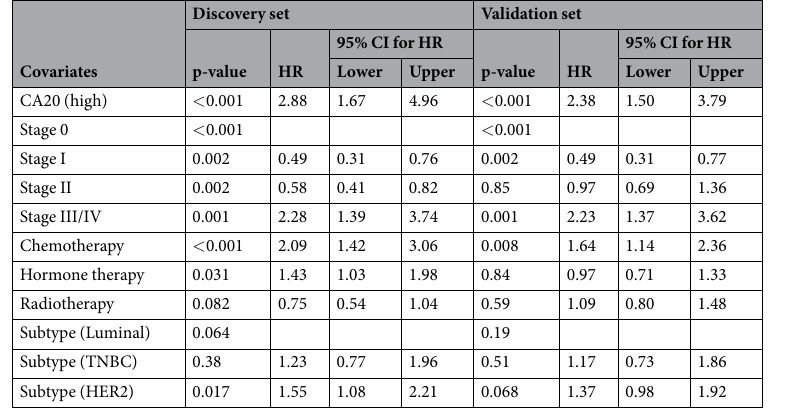
Table 3. Final multivariable Cox proportional-hazards models of breast cancer-specific survival including CA20 and CIN25 (stratified by average scores) in full models using METABRIC data. HR = Hazard Ratio; CI = Confidence